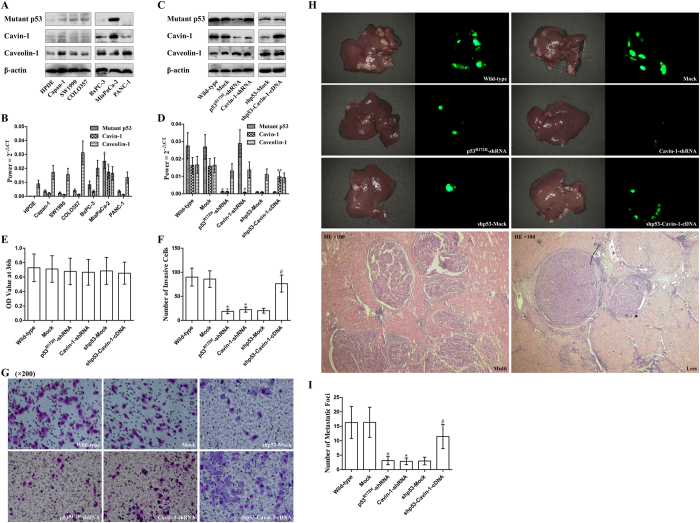
Mutant p53 drives invasiveness and metastasis of pancreatic cancer cells in vitro and in vivo through the upregulation of cavin-1.(A,B) Six human pancreatic cancer cell lines and one human pancreatic duct epithelial cell line (HPDE) were used to screen the level of mutant p53, cavin-1 and caveolin-1 protein, and mRNA expression by western blot (WB) and quantitative real-time polymerase chain reaction (qRT-PCR), respectively. (A) WB was performed as described23. For the detection of p53, an antibody that can only recognize mutant, but not wild-type, p53 was used. (B) Levels of mRNA were assessed by qRT-PCR and normalized to the corresponding internal β-actin signal (ΔCT); the relative gene expression values were expressed as 2−ΔCT
32. *P < 0.05, compared with each group. (C,D) Expression of mutant p53, cavin-1, and caveolin-1 after shRNA treatment was validated by WB and qRT-PCR. *,#P < 0.05, compared with the wild-type and mock group; **P < 0.05, compared with the shp53-mock group. (E) A Cell Counting Kit-8 was used to assay cell proliferation. No significant difference was found among groups. OD, optical density. (F,G) Cell invasiveness was assayed in Matrigel-coated Transwell Invasion Chambers. Cell cultures were incubated for 72 h, and the cells that passed through the membranes were counted (at ×200 magnification). *P < 0.01, compared with the mock group; #P < 0.05, compared with the shp53-mock group. (H,I) Representative bioluminescence and hematoxylin-eosin (HE) images of tumor metastatic foci in nude mouse livers (n = 6). The morphology was detected in general, and the number was counted. *P < 0.05, compared with the mock group; #P < 0.05, compared with the shp53-mock group.